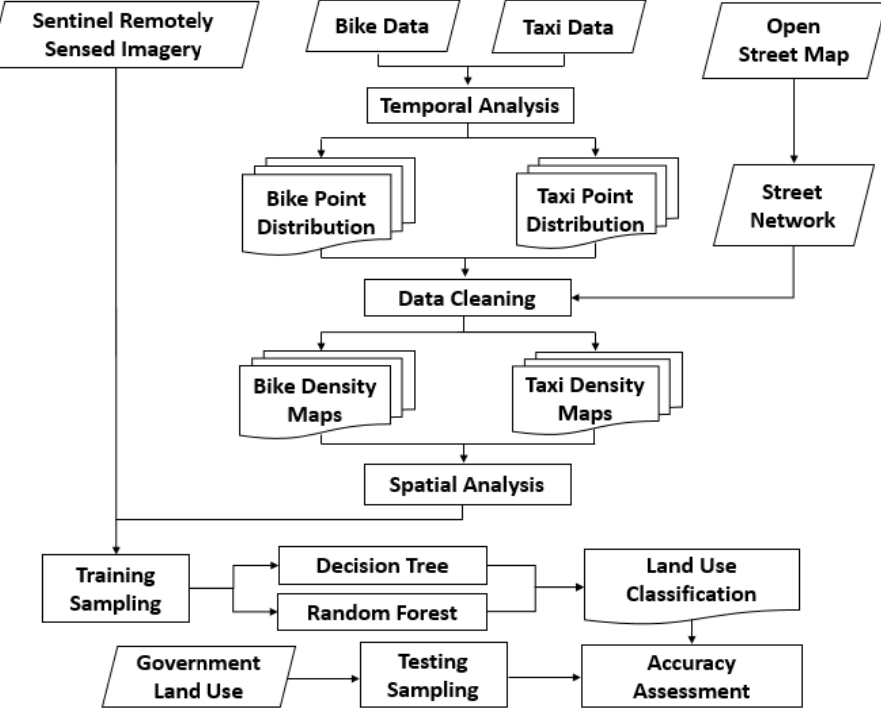
Figure 2. Flowchart of sensing and identifying land uses, including temporal and spatial analysis, data cleaning, and machine learning (decision tree and random forest).